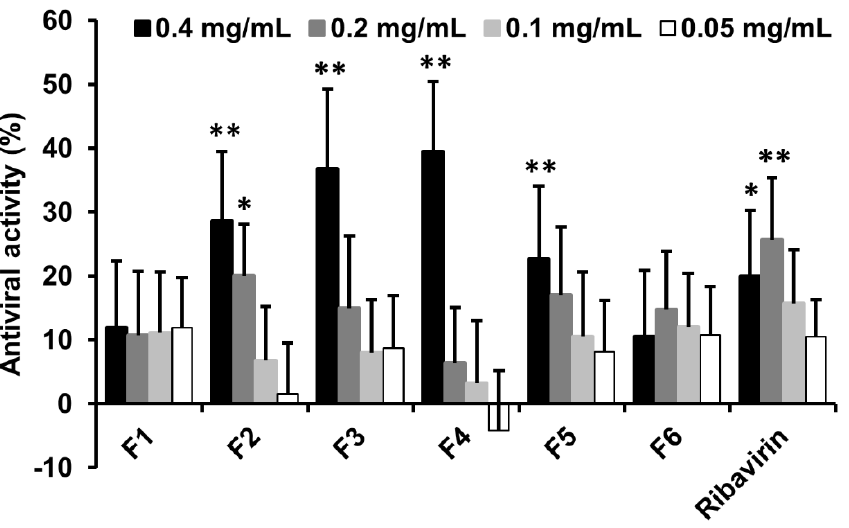
Figure 5. The antiviral effects of BLG nanoparticle fractions against H1N1 infection in the MDCK cells. MDCK cells were pre-incubated with 100 TCID 50 H1N1 for 2 h at 34 ◦ C and treated with the BLG-NPs fractions at the concentration of 0.05–0.4 mg/mL at 34 ◦ C. MDCK cell viability of cells was evaluated by MTT assay. Values are expressed as the mean ± SD ( n = 4). * p < 0.05, ** p < 0.01 compared to the virus group using the two-way ANOVA followed by Dunnett’s multiple comparisons test.